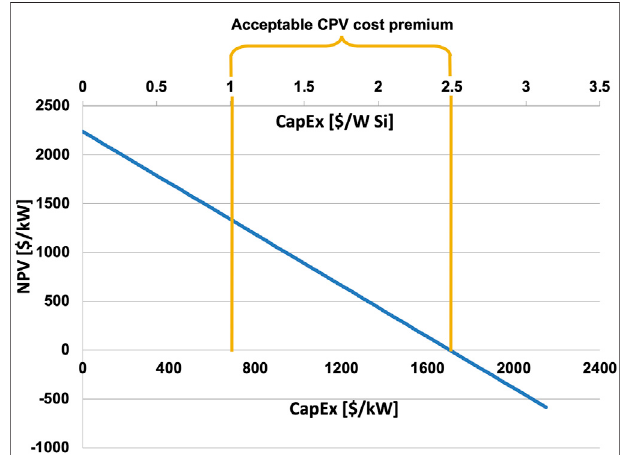
FIGURE 10 | Net present value of a TI-CPV system based on the performance model; the cost premium is the increase in CapEx over a conventional ground-mounted system that can be tolerated while still breaking even at current prevailing solar electricity prices.